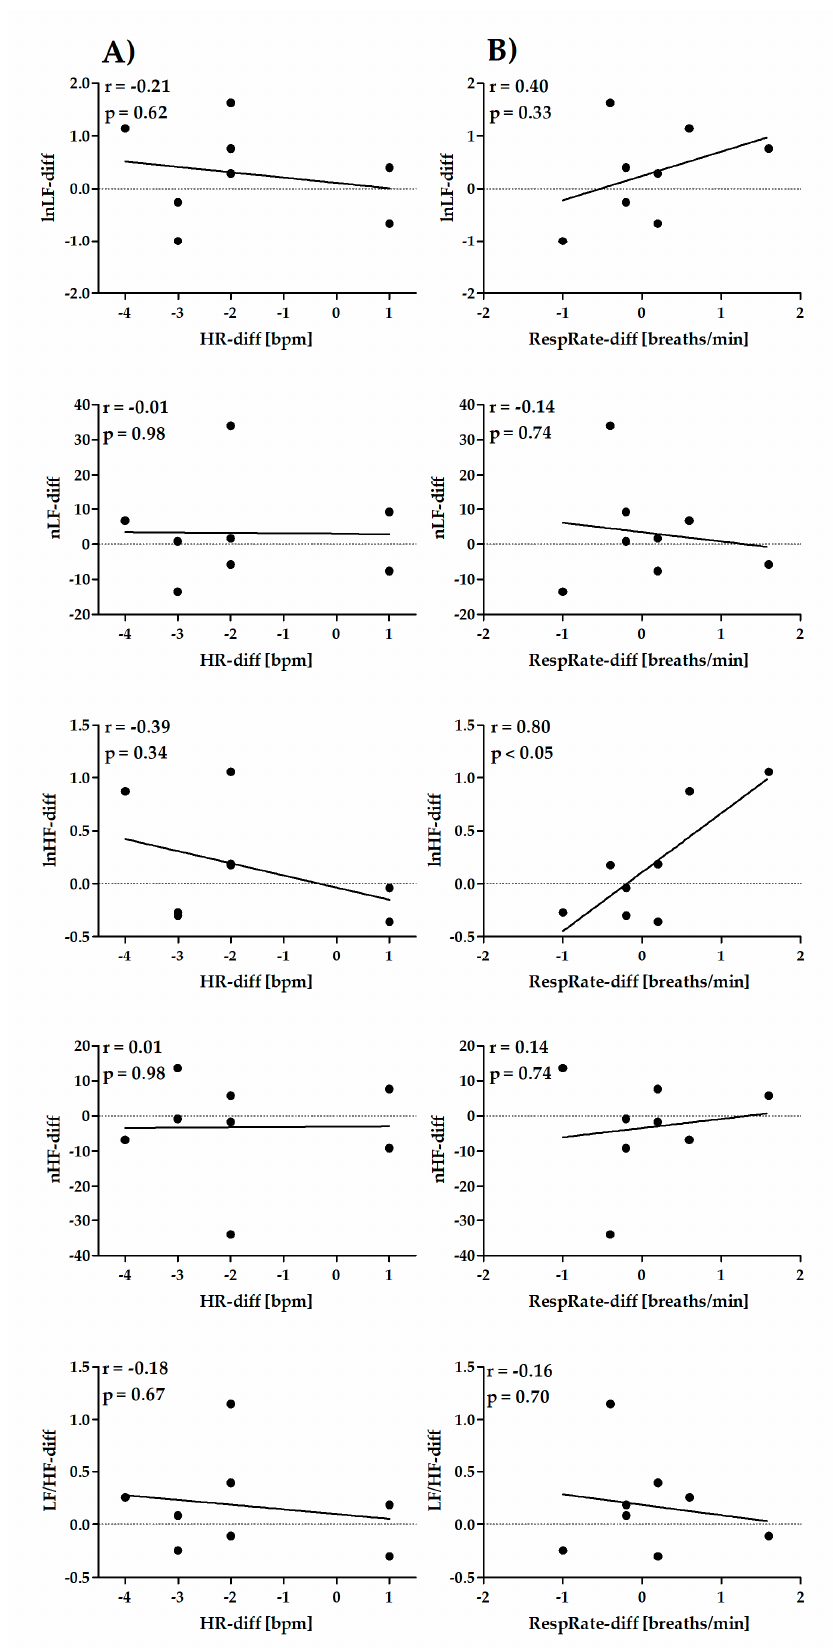
Figure 5. Pearson’s correlation coefficient between Retest–Test differences in frequency-domain short-term (5 min) HRV parameters and differences in HR (HR-diff) (column A ) or RespRate (RespRate-diff) (column B ).